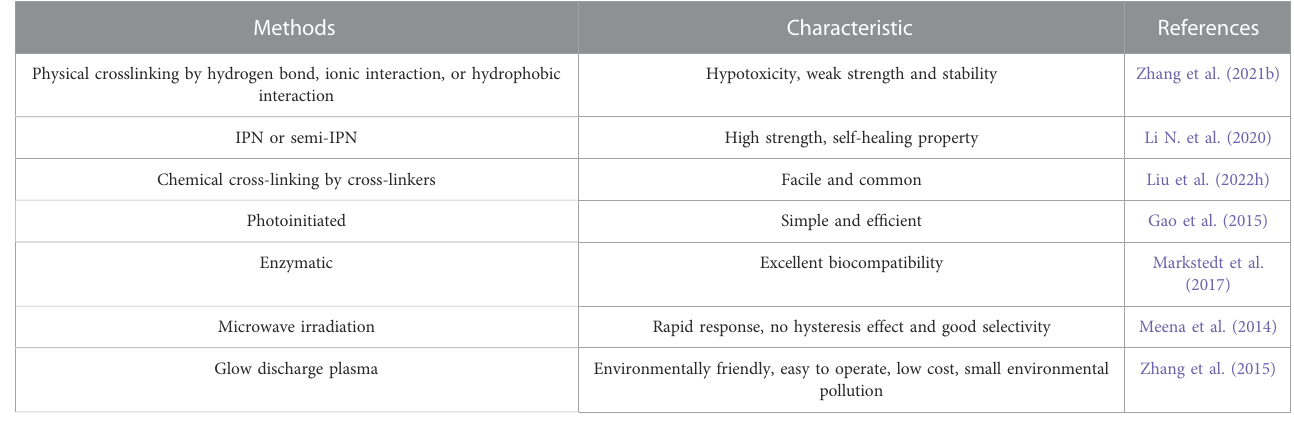
TABLE 1 Fabrication methods and their